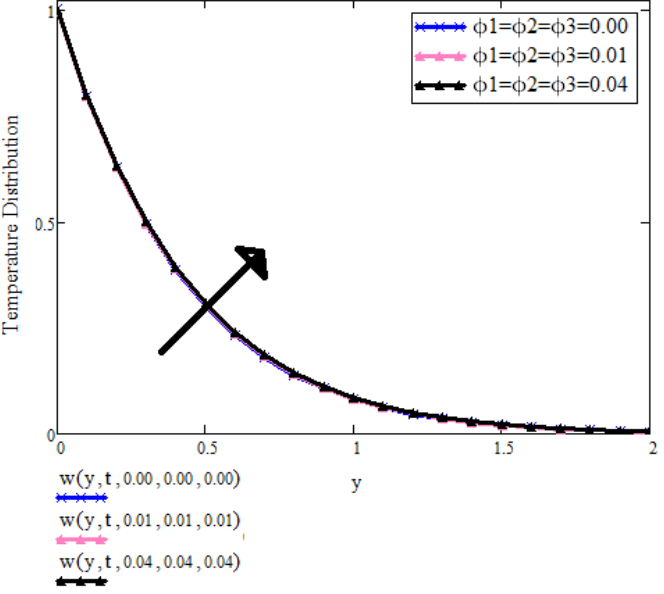
Figure 3. T ( y , t ) with φ 1 , φ 2 , φ 3 when t = 1, a = 0.3, λ = 0.7, Pr = 6.2, β 1 = 0.5. Figure 4 is showing the behavior of Pr with respect to the temperature field. When